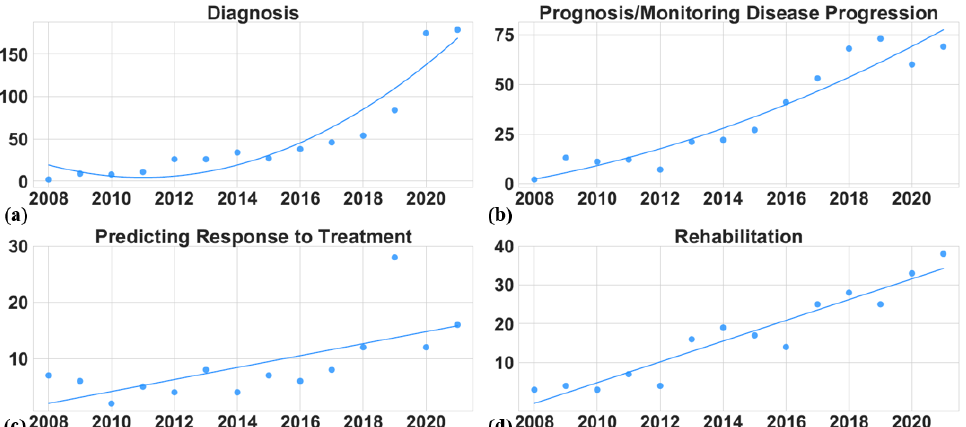
Figure 6. The number of research publications (2008–2021) divided by PD application area: ( a ) pub- lications about diagnosis, ( b ) publications about prognosis and monitoring, ( c ) publications about predicting patient responses to treatments, and ( d ) publications about